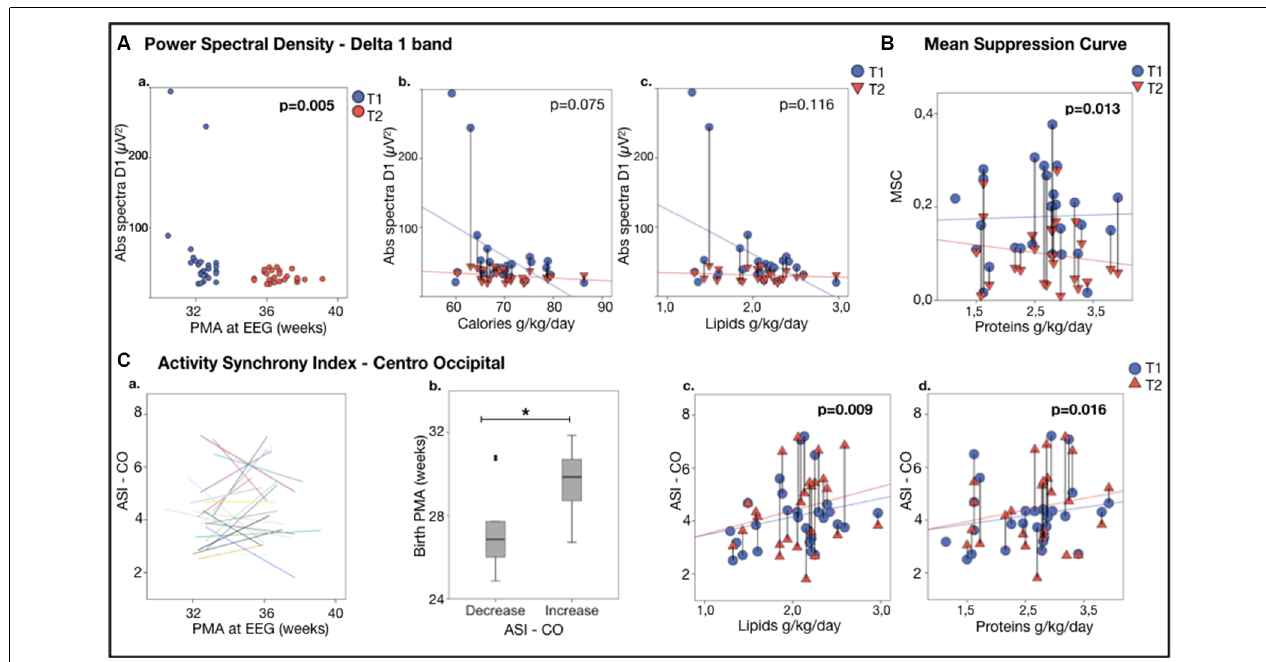
FIGURE 2 | EEG features vs. nutrition. (Aa) Power Spectral Density for Delta 1 band: Delta 1 band power (absolute spectra) vs. age at the recording. (Ab,c) Delta 1 band power vs. nutrient intake during the first week of life. Note the significant decline in the delta 1 power as a function of calories (Ab) and lipids (Ac) . (B) Continuity, expressed as Mean Suppression Curve (MSC) vs. nutrition; note the significant higher increase from T1 to T2 in MSC as a function of the mean daily protein intake in the first week of life. (C) Activity Synchrony Index over Centro-Occipital areas vs. nutrition. (Ca) Individual trajectories of Centro-Occipital ASI (C-O ASI) as a function of age, showing that in half of the individuals the ASI increased. (Cb) A comparison of these subgroups showed that gestational age at birth was higher in the infants, showing ASI increase (29.6 ± 1.6 vs. 27.7 ± 2.3 weeks PMA, * p = 0.023). C-O ASI vs. 1-week lipids (Cc) and proteins (Cd) intake. Vertical lines